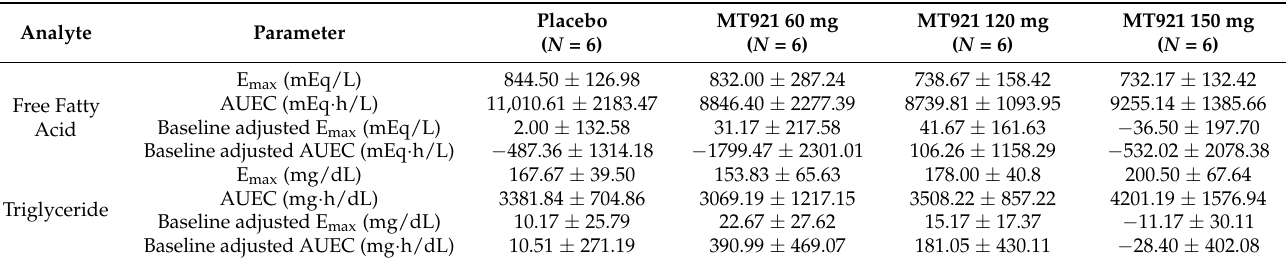
Table 3. Pharmacodynamic parameters by dose